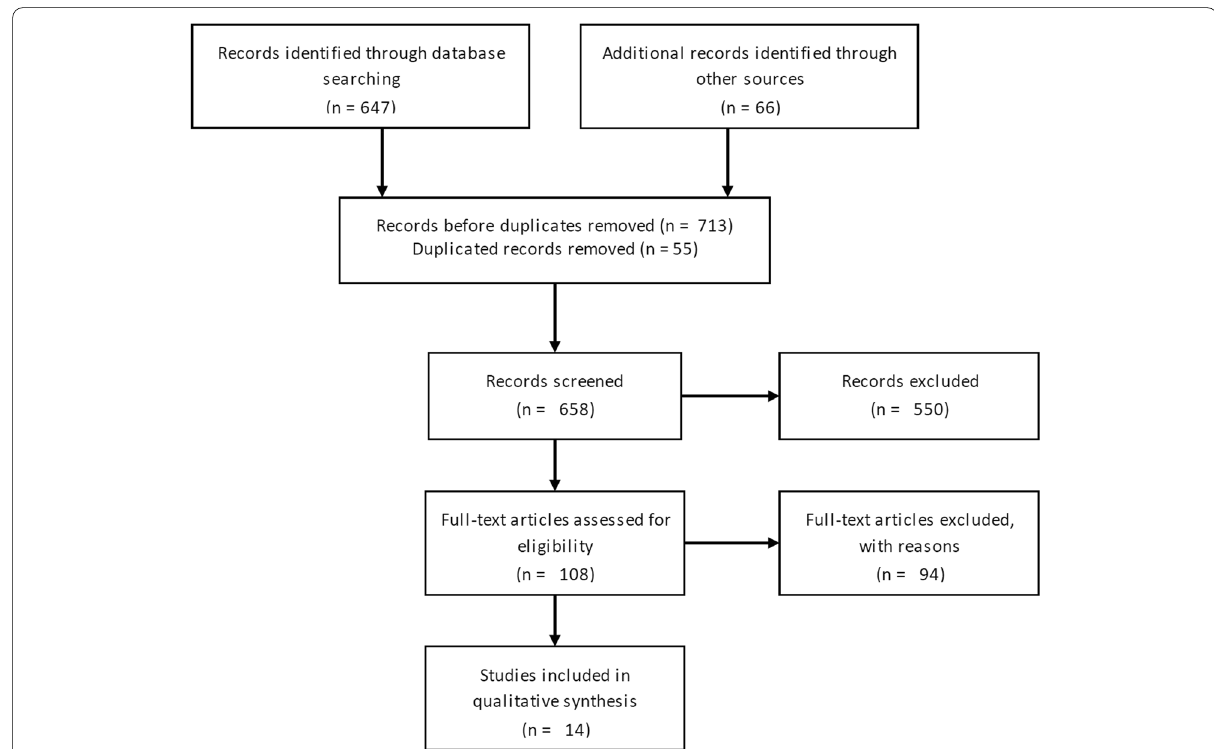
Fig. 1 Literature search, PRISMA flow